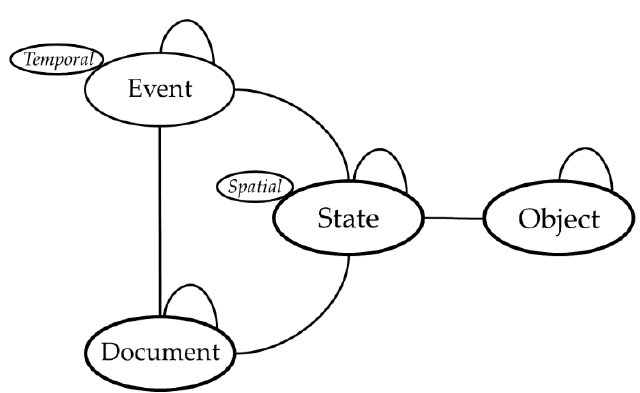
Figure 7. Metamodel’s legend.